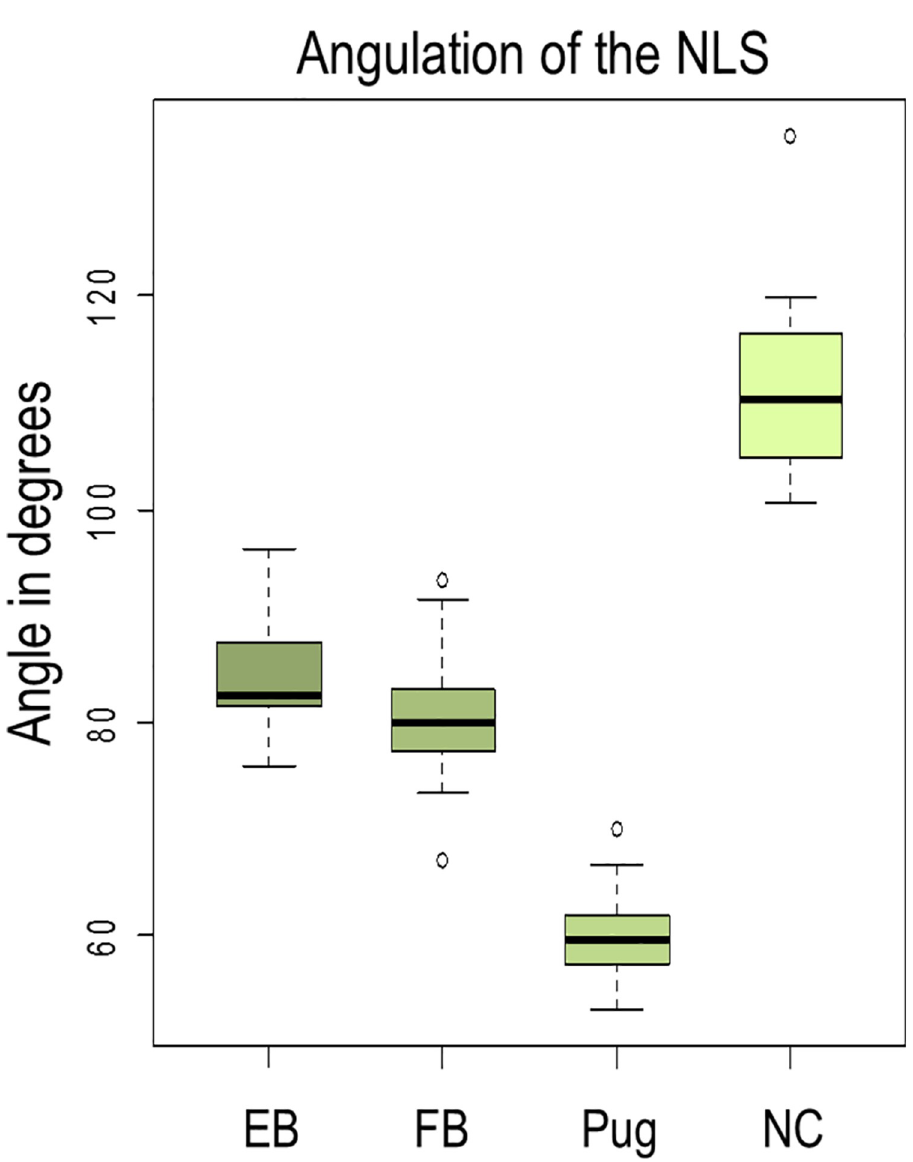
Fig 6. Angulation of the nasolacrimal system (NLS). The angle in degrees in 10 English Bulldogs (EB), 17 French Bulldogs (FB), 22 Pugs, and six normocephalic dogs (NC) presented in a box-and-whisker diagram.